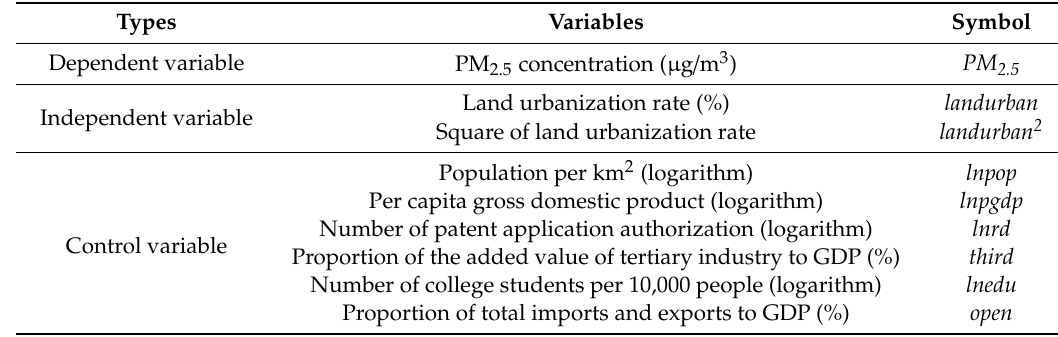
Table 1. Variable definitions.